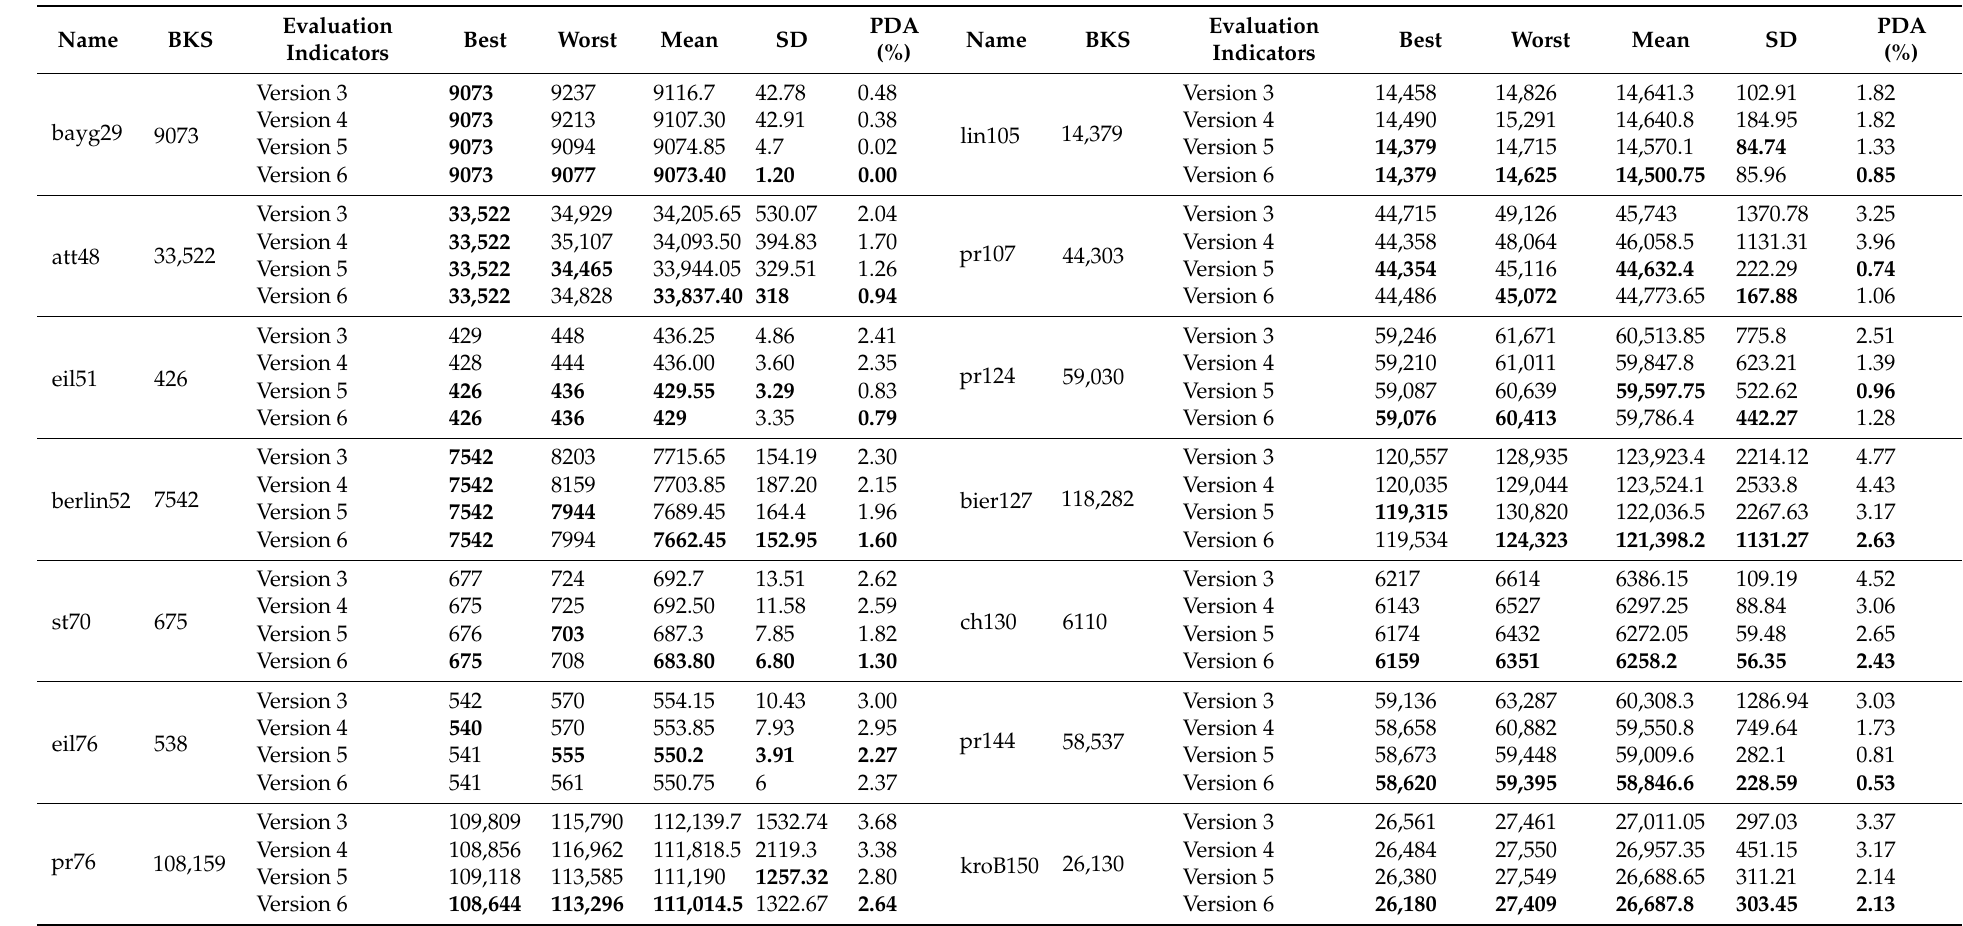
Table 7. Experimental results of the DCPA and its different